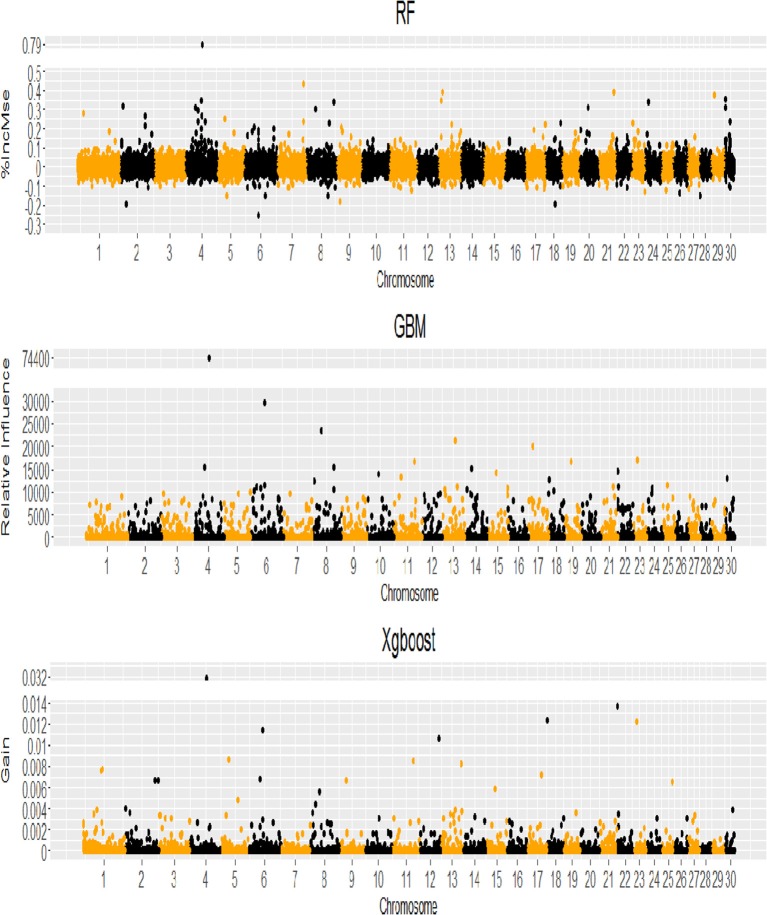
Genome-wide profile of SNP variable importance values for RF, GBM and XgBoost analyses (VIM = %IncMse for RF, Relative Influence for GBM, Gain for XgBoost).